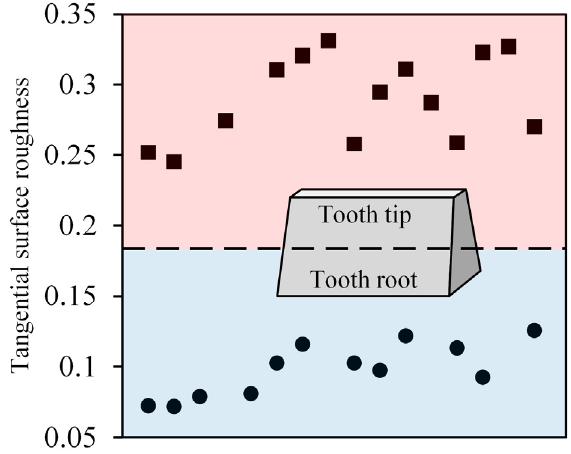
Figure 8. Distribution of tangential roughness values on the tooth surface.